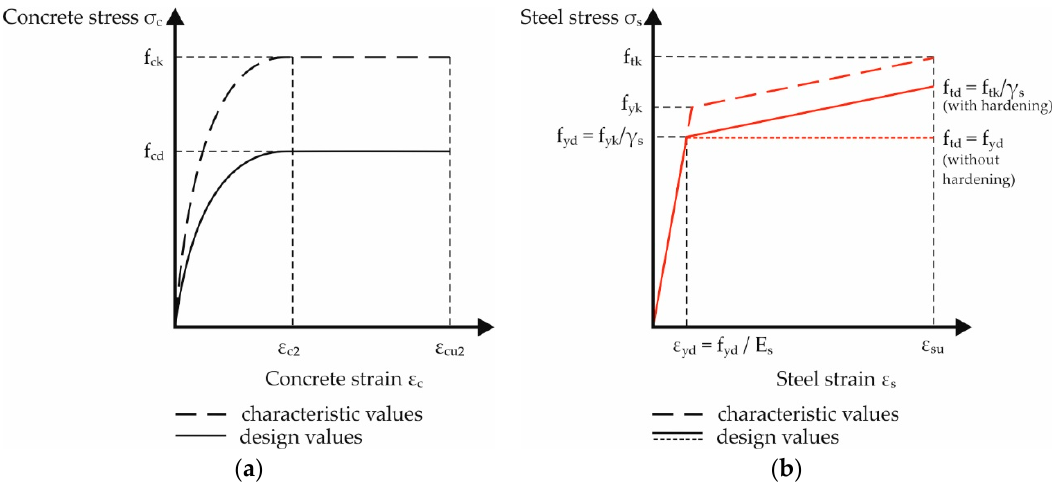
Figure 2. Stress-strain relationships of the reinforced concrete (RC) components according to European code: ( a ) parabola-rectangle diagram for concrete under compression; ( b ) bilinear diagrams for reinforcing steel (tension and compression).